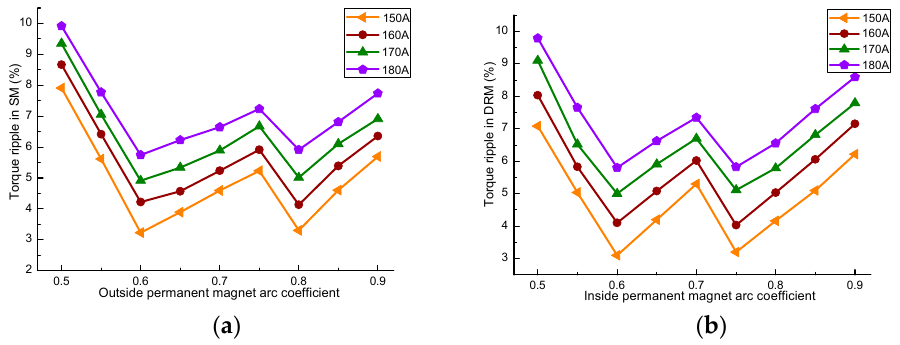
Figure 9. Variation of torque ripple in SM and DRM with permanent magnet pole arc coefficient: ( a ) SM; ( b ) DRM.